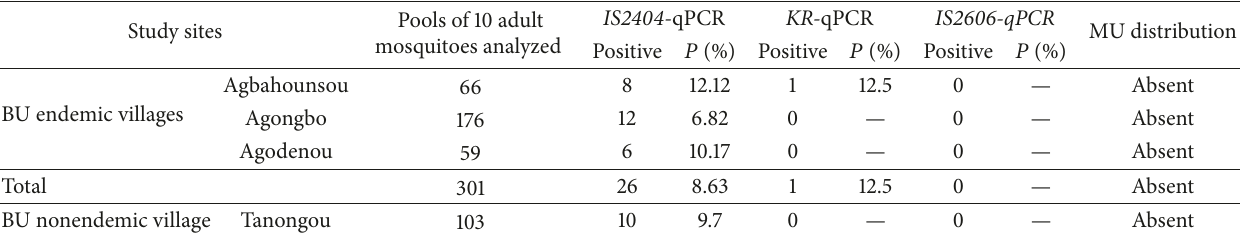
Table 2: Distribution of MU targets in field-caught adult mosquitoes.